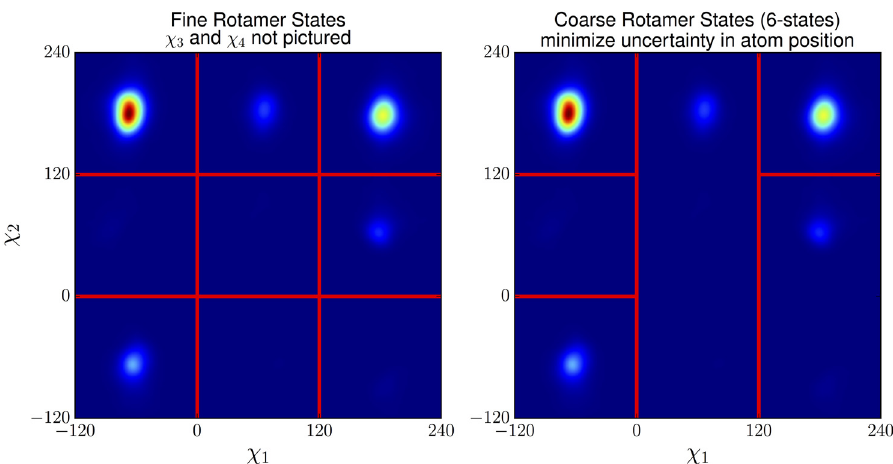
Fig 4. Example of optimized coarse states for arginine overlaid on the PDB distribution of the rotamer angles χ 1 and χ 2 . Each of the six coarse states contains only a single fine state that has high probability, so that the variance of dihedral angles within each coarse state is